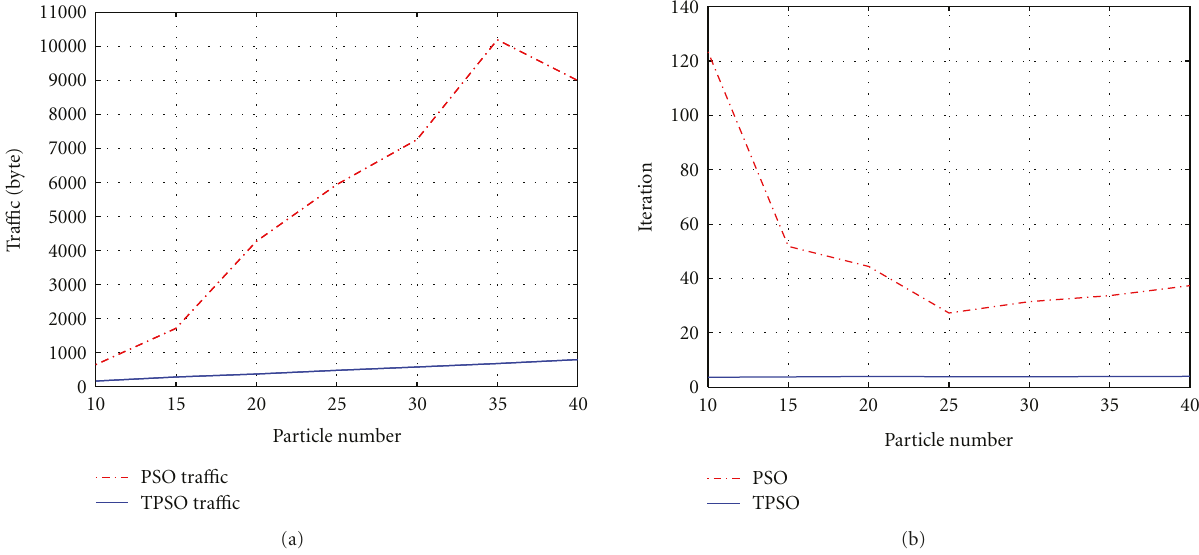
Figure 11: (a) TPSO tra ffi c overhead in relation to PSO based on Table 2 and (b) convergence speed of particles (iterations) for TPSO and PSO algorithms in the ad hoc network with 50 nodes for di ff erent number of particles.